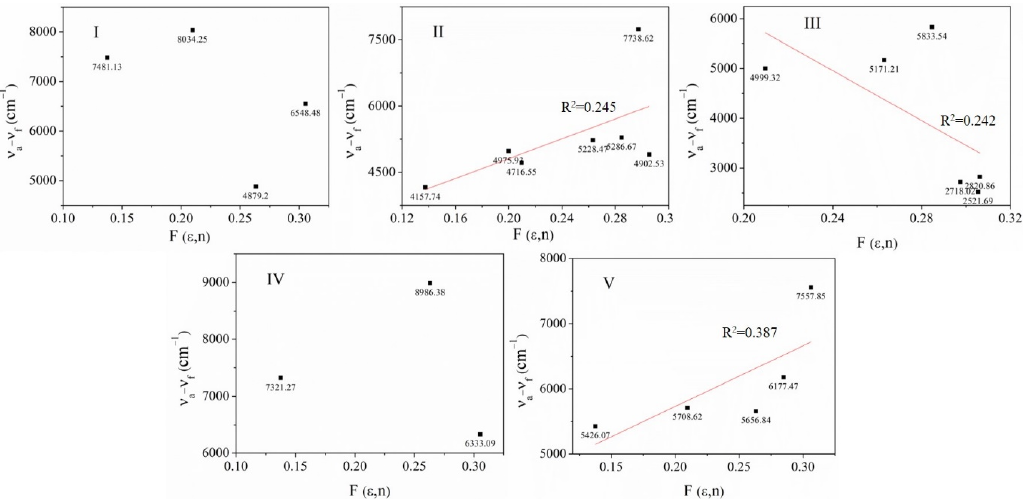
Figure 9. Plots of ῡ a – ῡ f (cm − 1 ) versus F( ε , n) of I – V in the solvents.